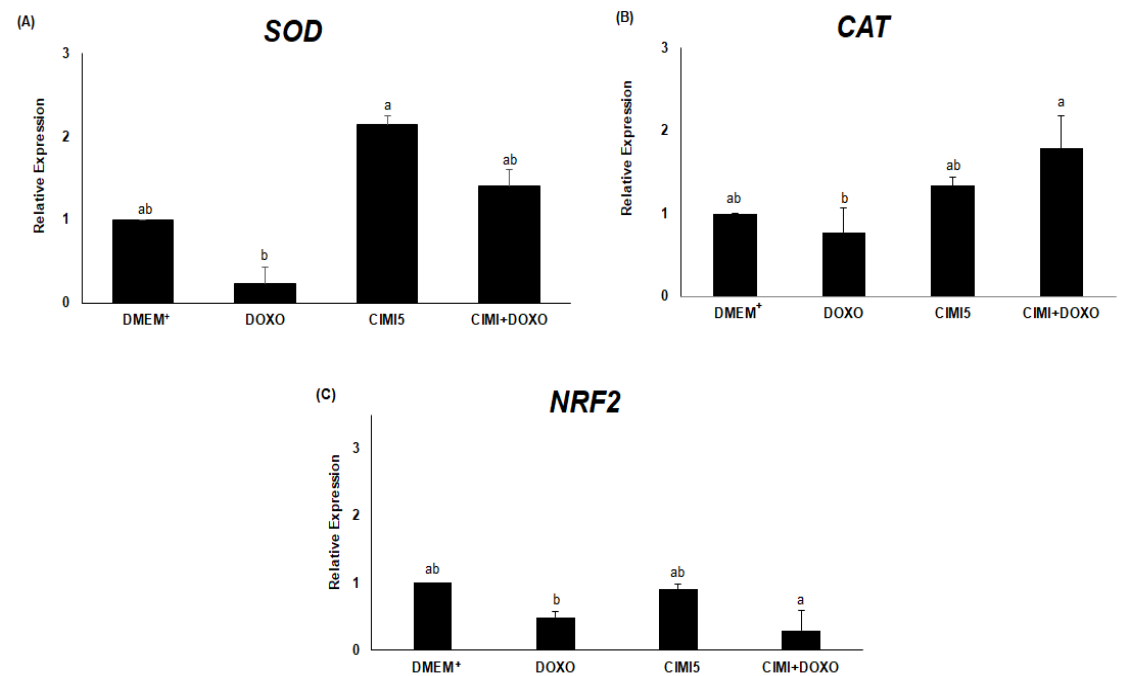
Figure 13. The levels of mRNA for ( A ) SOD, ( B ) CAT and ( C ) NRF2 in ovaries (n = 04 ovaries per treatment) after cultured in control group (DMEM + ), DOXO (0.3 μg /mL), CIMI (5 ng/mL) and CIMI+DOXO (5 ng/mL + 0.3 μg /mL). Levels of mRNA for SOD, CAT and NRF2 were analyzed by the Kruskal-Wallis test, followed by the Dunn comparison. a, b different lowercase letters indicate significant difference between treatments ( p < 0.05).